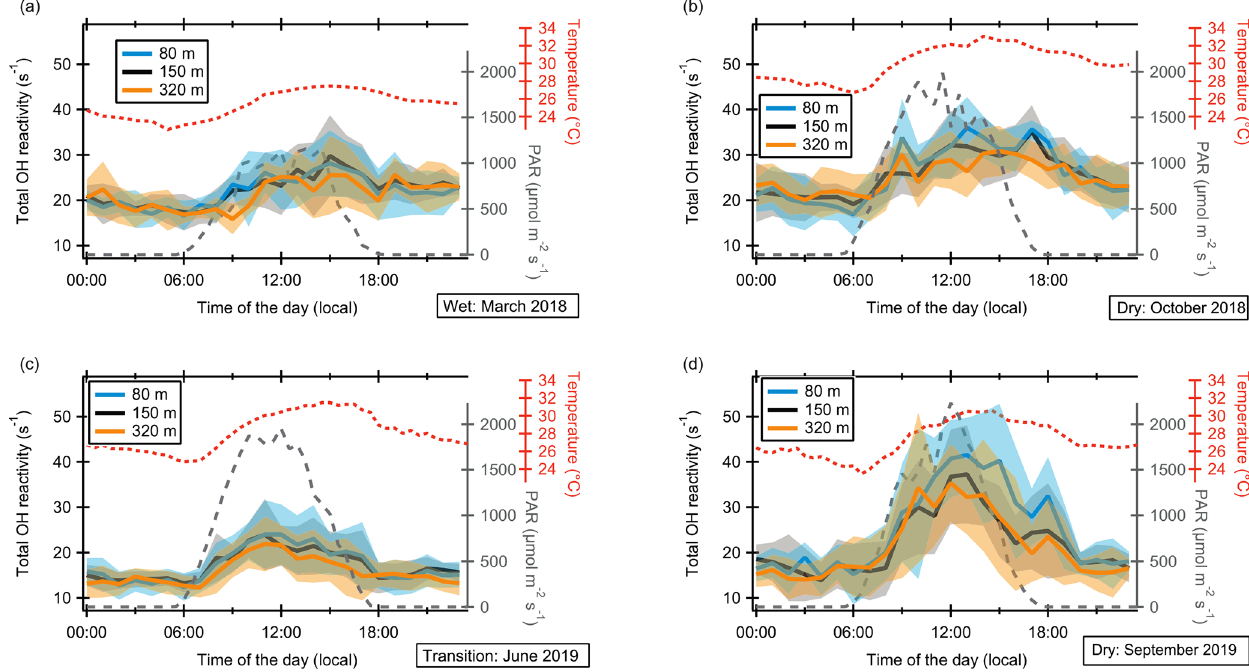
Figure 2. Diel cycles of total OH reactivity at 80, 150, and 320m height a.g.l. at the ATTO tall tower for four measurement periods: (a) March 2018 (wet season), (b) June 2019 (wet–dry transition season), (c) October 2018 (dry season), and (d) September 2019 (dry season). Values are hourly diel averages over each measurement period. The shaded areas represent the standard deviation of the data. PAR (photosynthetically active radiation) and temperature were measured at 81m height a.g.l. at the 80m walk-up